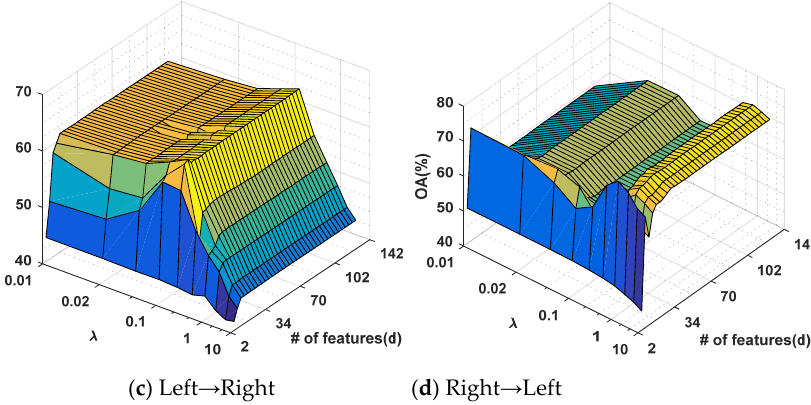
Figure 8. OA versus the number of subspaces d and the parameter λ of JDA (trained with primal) for the ROSIS ( a , b ) and Houston ( c , d ) data sets: (Source → Target).